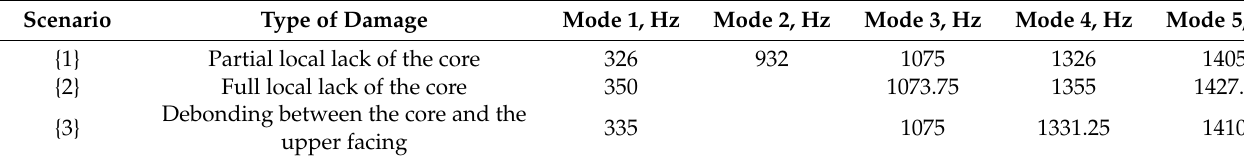
Figure 3. FRFs of the tested sandwich structures. Table 1. The eigenfrequencies of the tested sandwich structures.